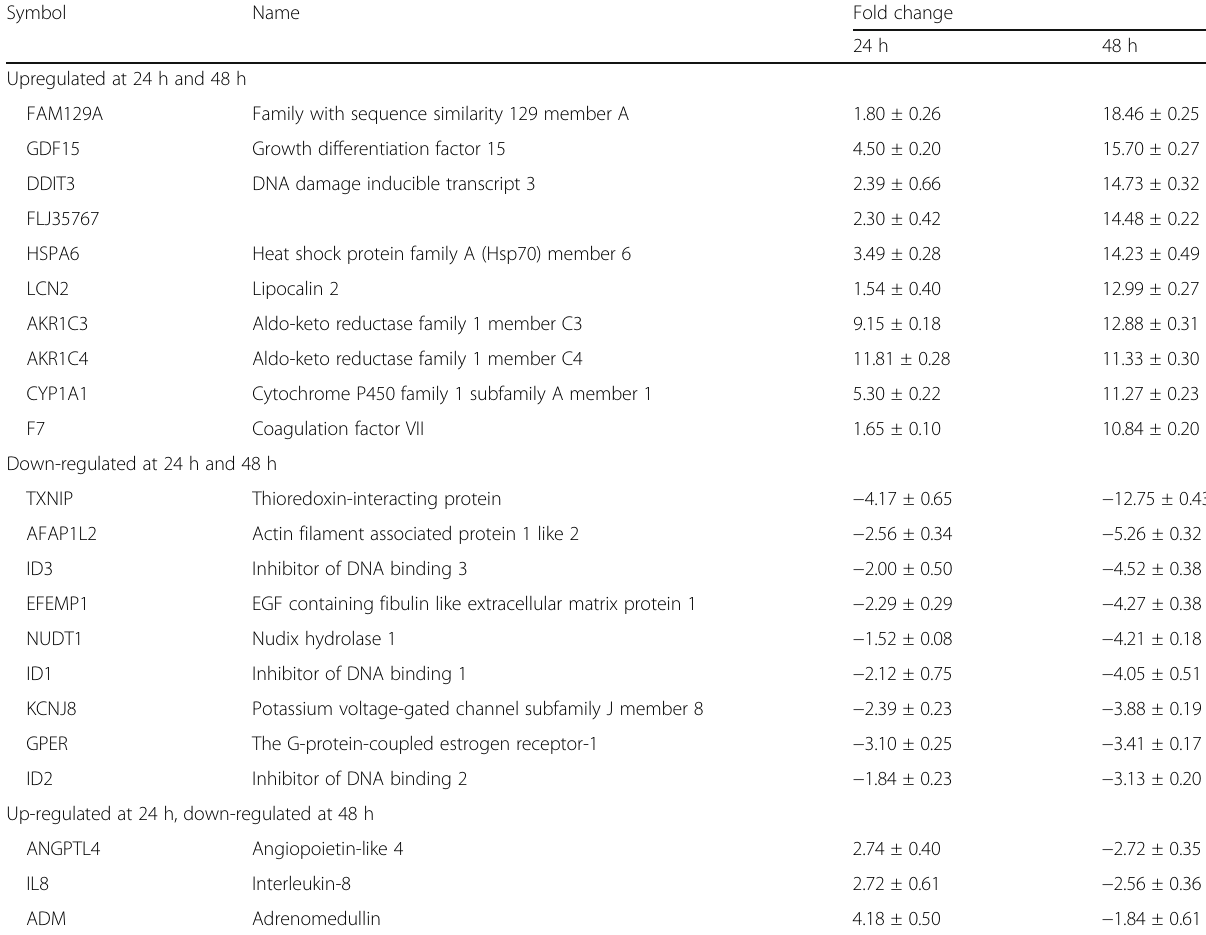
Table 2 Top differentially expressed genes at both time points